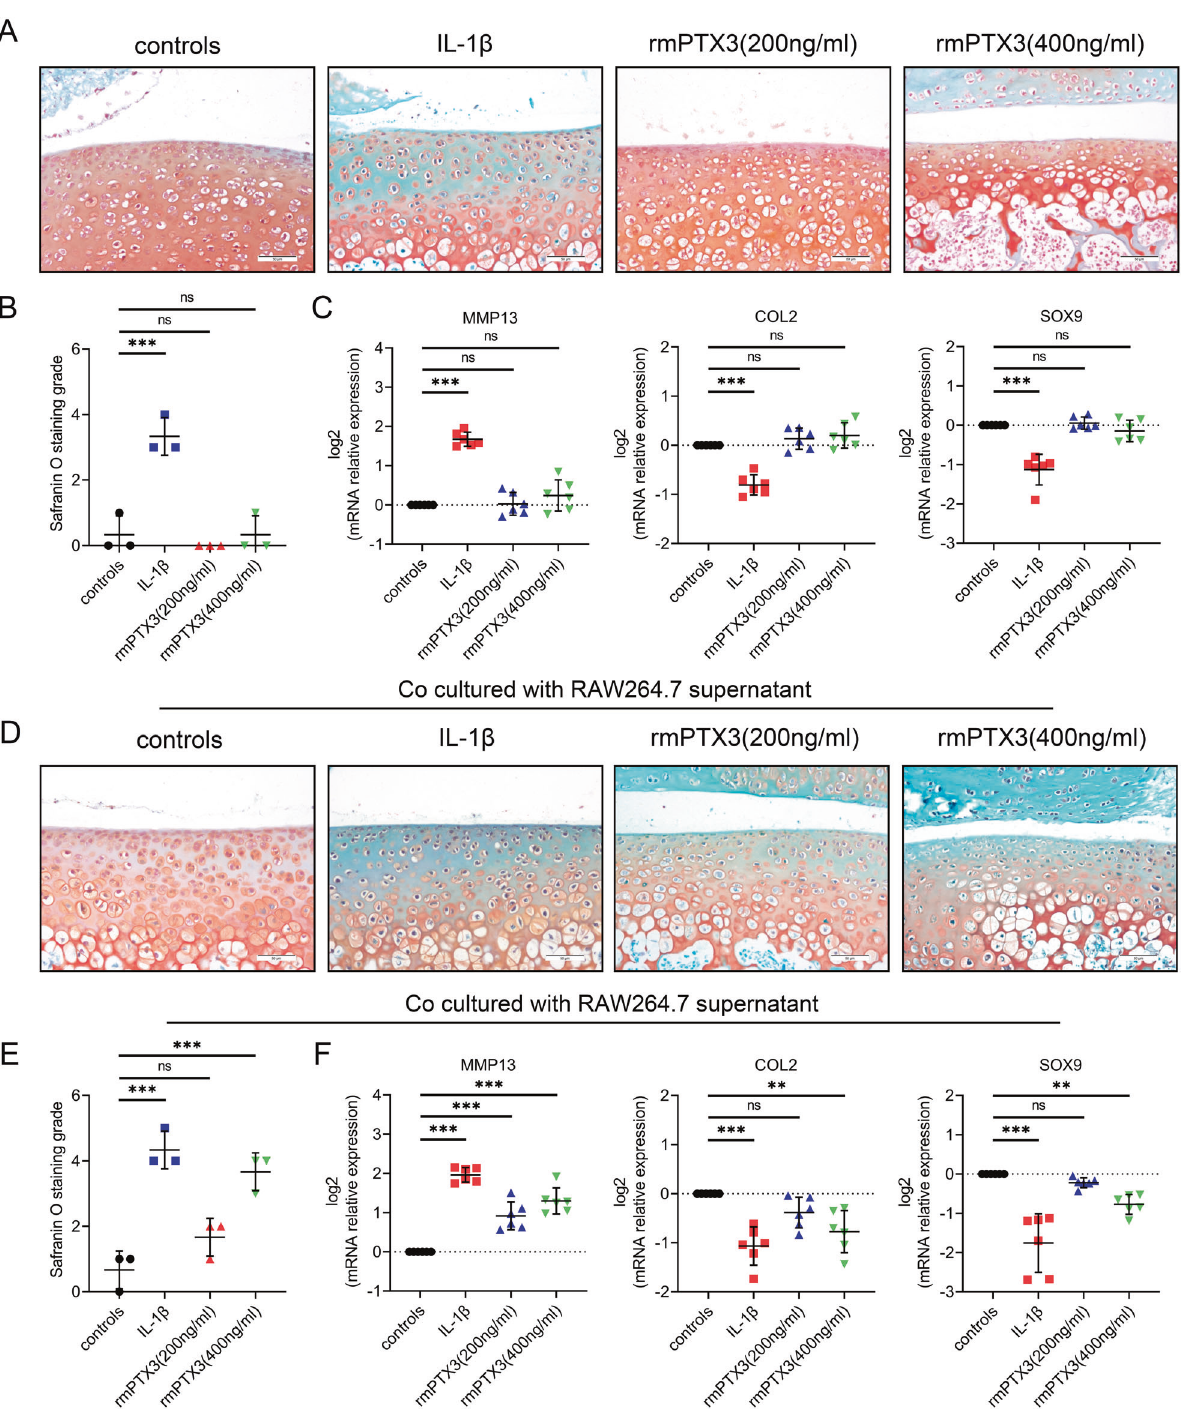
Fig. 4 PTX3 has indirect effects on chondrocyte metabolism through regulation of macrophage polarization. A , B Safranin O staining and grade of mouse tibial plateaus cartilage explants treated with IL-1 β or rmPTX3, n = 3 per group; Scale bar: 50 µm. C Relative mRNA expression levels of MMP13, COL2, and SOX9 in IL-1 β - or rmPTX3-treated primary murine chondrocytes, n = 6 per group. D , E Safranin O staining and grade of mouse tibial plateaus cartilage explants co-cultured with supernatants of RAW264.7 (RAW264.7 was treated with IL-1 β and rmPTX3), n = 3 per group; Scale bar: 50 µm. F Relative mRNA expression levels of MMP13, COL2 and SOX9 in primary murine chondrocytes co-cultured with supernatants of RAW264.7 (RAW264.7 was treated with IL-1 β or rmPTX3), n = 6 per group. * P < 0.05, ** P < 0.01, *** P < 0.001, ns not signi fi cant. Data are shown as means ± SD. Statistical analyses were conducted by Kruskal – Wallis test followed by Dunn ’ s multiple comparisons test ( B and E ) or one-way analysis of variance followed by Dunnett ’ s multiple comparison test ( C and F